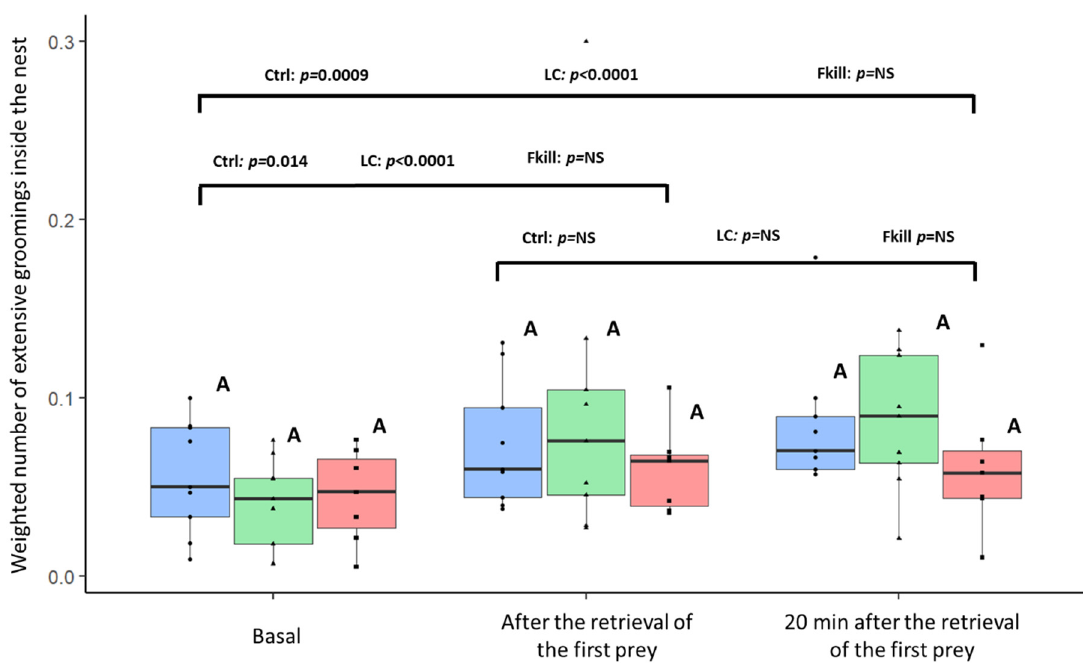
Figure 4. Weighted number of extensive groomings (EG) inside the nest before the introduction of food (basal), after the retrieval of the first prey inside the nest and twenty minutes later. The weighted number was calculated by summing the number of EG within 5 min divided by the number of ants inside the nest. Blue: control flies (n = 27), green: conidia-covered flies (n = 27), red: fungus-killed flies (n = 21). The horizontal bar within the boxes represents the median; the upper and lower boundaries of the boxes represent respectively the 75th and 25th percentiles, while the whiskers extend to the smallest and largest values within 1.5 box lengths. For each condition, p -values are given for pairwise comparisons between observation sessions (NS = non-significant, p > 0.05). Within each observation session, conditions sharing a common letter were not significantly different.